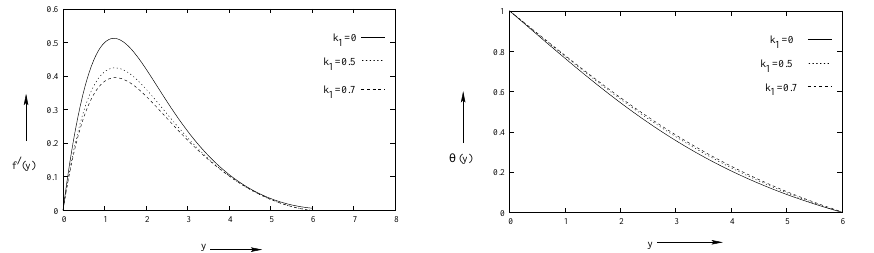
Figure 3. Variation of temperature with y for various values of k 1 when λ = 0 and